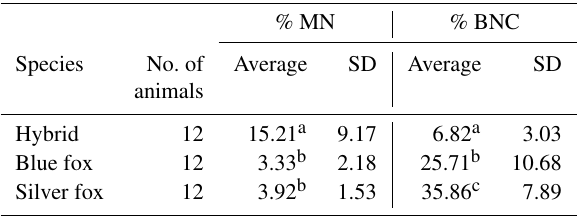
Table 1. Percentages of BNC and BNC + MN % MN % BNC Species No. of